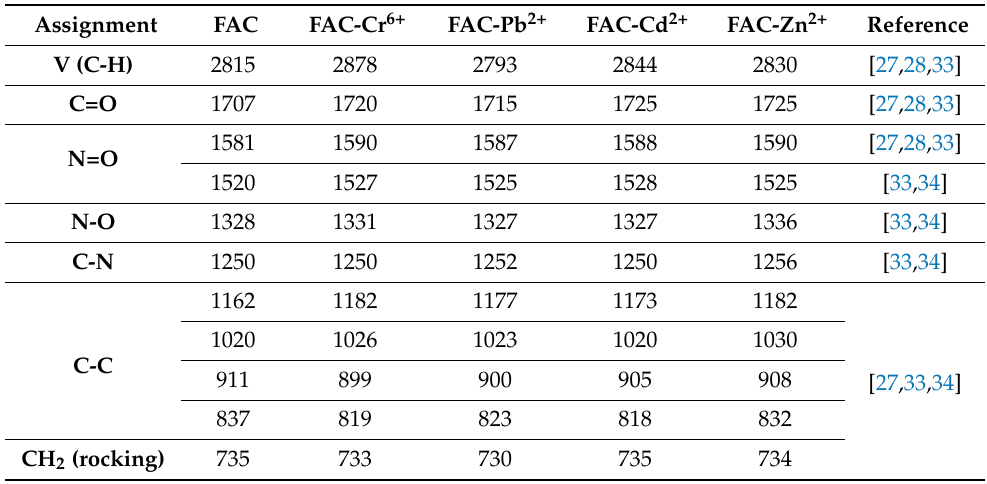
Figure 3. FTIR spectra of FAC before and after the adsorption of the metal ions. Table 1. Fourier transformed infrared spectroscopic vibrational bands of the different functional groups in FAC before and after the metal ion